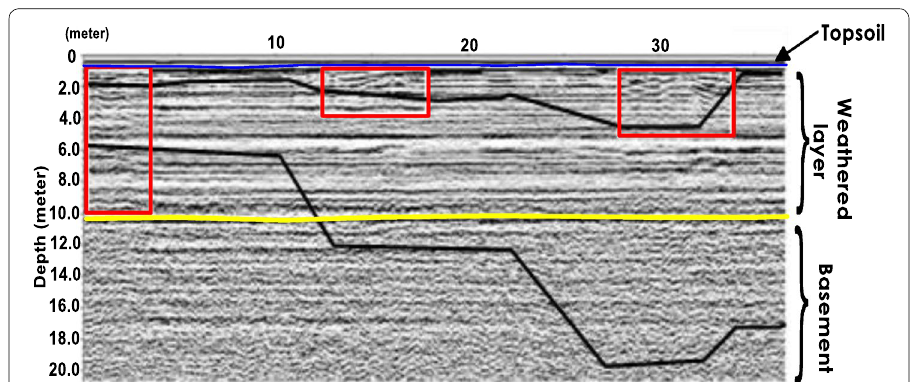
Fig. 17 20: GPR profiles G1–G6